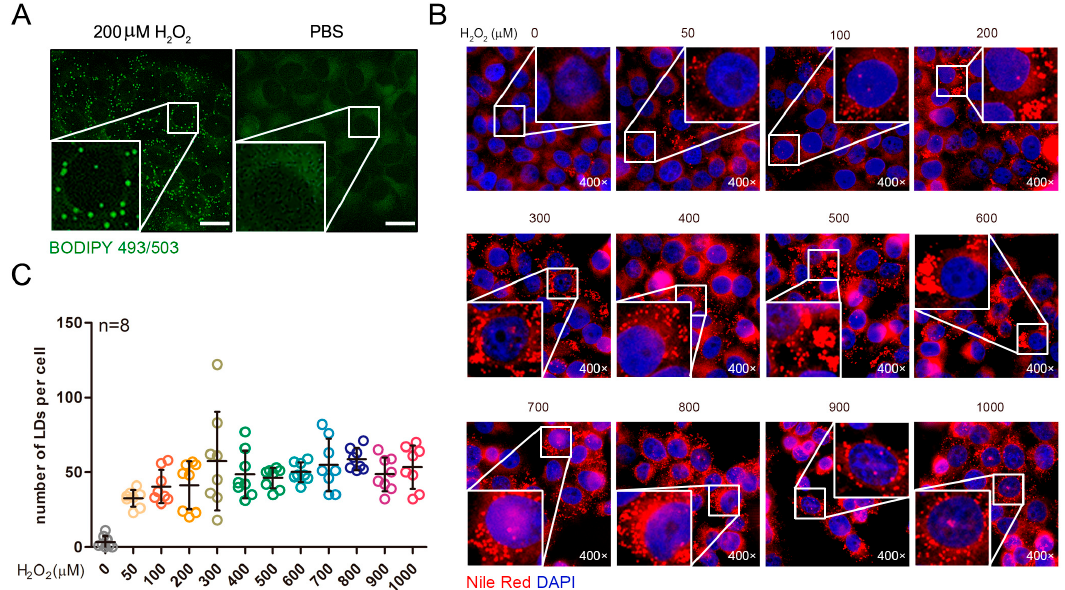
Figure 1. Increased lipid droplets in HepG2 cells after hydrogen peroxide treatment were not dose dependent. ( A ) The cells were labeled with lipid droplets after treatment with 200 µ M hydrogen peroxide. Scale bar = 10 µ m. ( B ) Labelling of the intracellular lipid droplets after treatment of the cells with different concentrations of hydrogen peroxide. ( C ) Statistics on the number of lipid droplets in the cell.